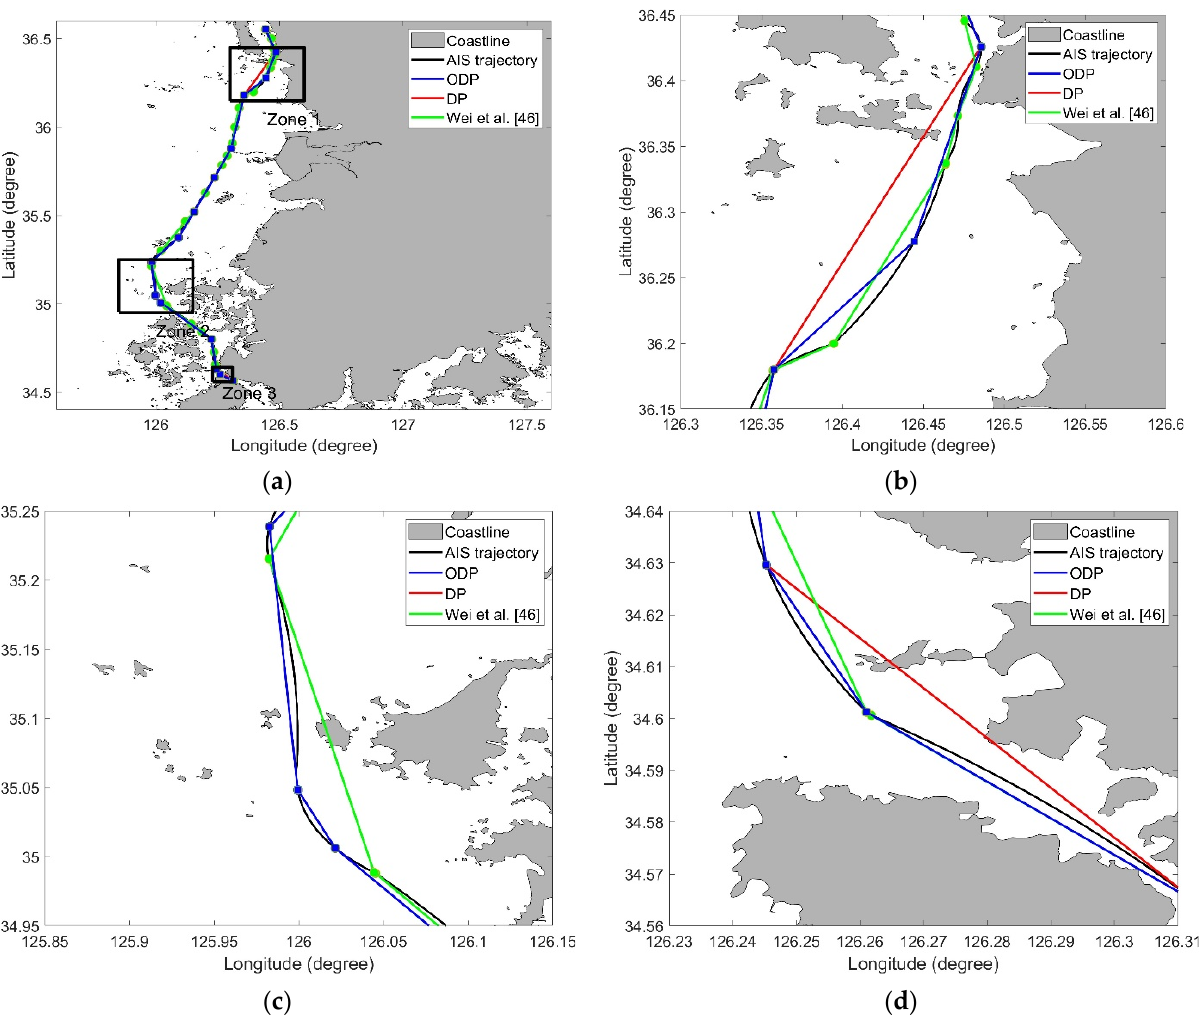
Figure 10. Results obtained from the ODP and DP algorithms for trajectory 4 ( 𝜖 = 1.0 ): ( a ) Overview; ( b ) Zone 1 in ( a ); ( c ) Zone 2 in ( a ); ( d ) Zone 3 in ( a ) [46].